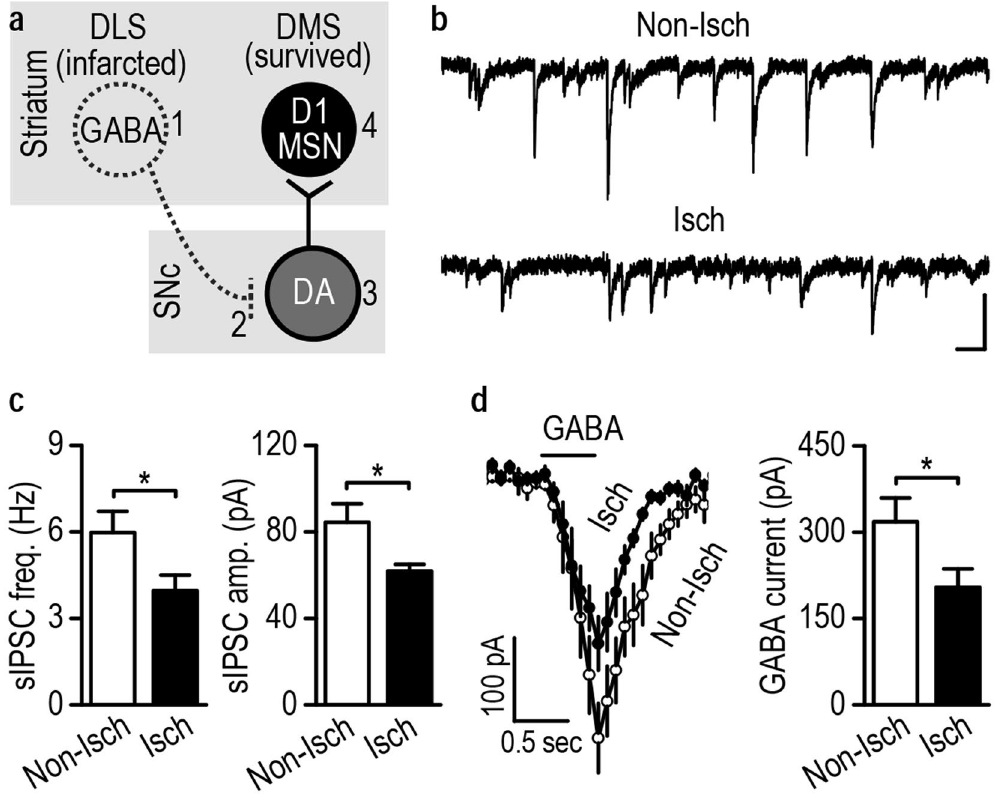
Figure 7. Stroke-mediated DLS infarction reduces GABAergic inputs to DMS-projecting SNc neurons. ( a ) Schematic of proposed changes in striatal and midbrain neurons after DLS infarction. The death of GABAergic DLS neurons (1) may disinhibit dopamine neurons (2) that project to the DMS, leading to increased activity of these neurons (3, 4). ( b ) Representative sIPSC traces in DMS-projecting SNc neurons on the Non-Isch and Isch sides. Scale bars: 50 ms, 100 pA. ( c ) Stroke-induced DLS infarction reduced the frequency and amplitude of sIPSCs in DMS-projecting SNc neurons. Left, bar graphs summarizing the average sIPSC frequencies. * p < 0.05. Right, bar graphs displaying the average amplitudes. * p < 0.05, t test. n = 12 neurons from 4 rats (Non-Isch) and 12 neurons from 5 rats (Isch) for both left and right graphs. ( d ) Stroke-induced DLS infarction resulted in lower GABA-induced currents in DMS-projecting SNc neurons. Left, changes in the holding current in DMS- projecting SNc neurons on the contralesional non-ischemic (Non-Isch) and ipsilateral ischemic (Isch) sides. Right, bar graphs summarizing the averaged GABA currents in SNc neurons on both sides. * p < 0.05, t test. n = 9 neurons from 5 rats per